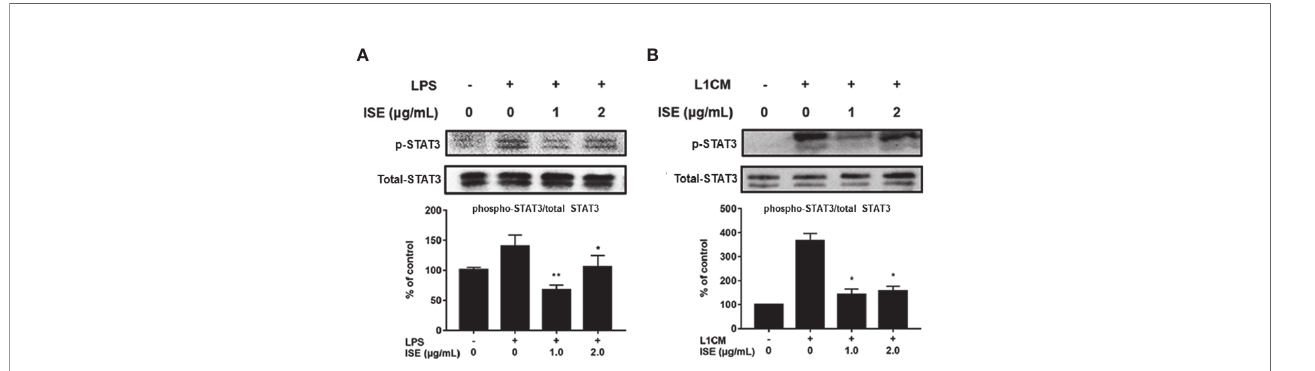
FIGURE 7 | Effects of ISE on STAT3 signal. RAW264.7 macrophages were pretreated with different concentrations of ISE for 1h and then stimulated by 1.0 m g/mL LPS or 3T3-L1CM for 30min. Total cell lysates were extracted, and then western blotting using speci fi c antibodies was used to determine the expression of p-STAT3 and STAT3 in LPS (A) and 3T3-L1CM (L1CM) stimulation (B) , respectively. The value of a control was set at 100%, and the relative value was presented as fold induction to that of the control, which was normalized to total STAT3. Statistical comparisons were made with each vehicle controls. The values are means ± SD, n = 3. * P < 0.05, ** P